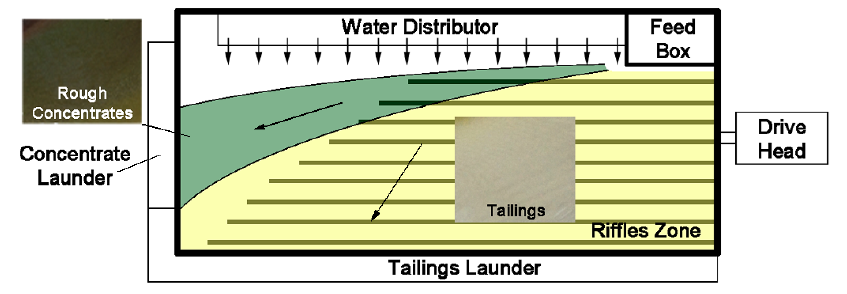
Figure 1. Samples used for flotation tests were obtained from the shaking table tailings.